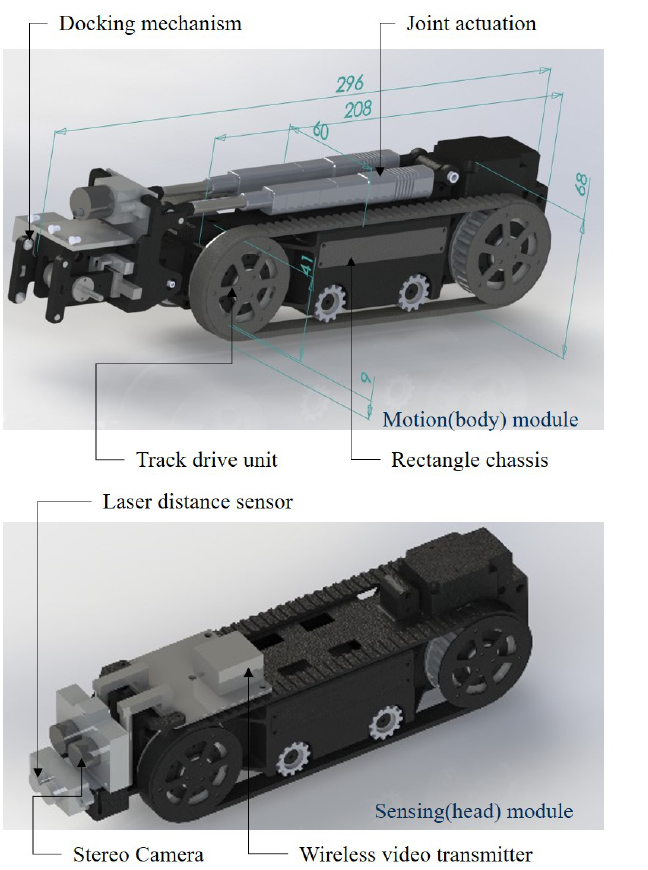
Figure 3. The overall design of SMMRob modules, including the motion module (default) and sensing module. In the self-assembled snake-like system, the motion module is a component of the body, whereas the sensing module is used as the head. The unit of length is